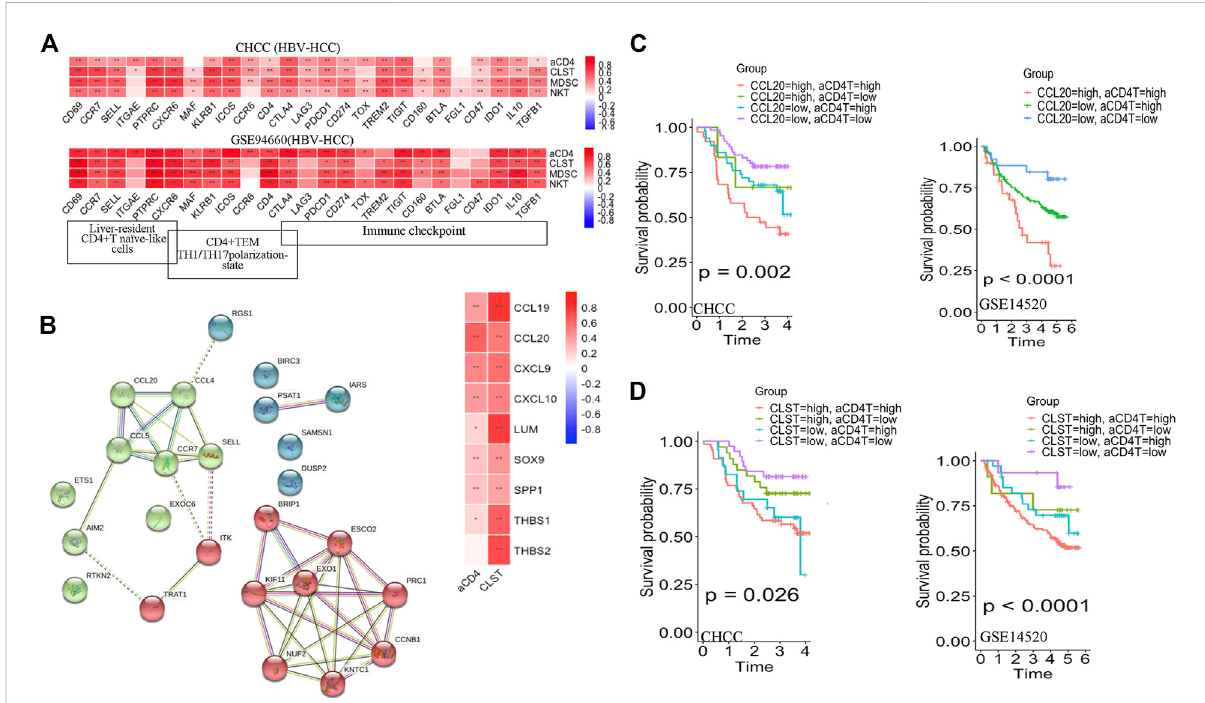
FIGURE 4 PrognosticvaluesofCLSTandaCD4forOSpredictioninHBV-HCC. (A) HeatmapsshowingcorrelationsbetweenCLST,aCD4,MDSC,NKT,and speci fi c immune genes in HBV-HCC. (B) PPI analysis of member genes belonging to aCD4 and correlations among aCD4, CLST, and hub gene expressionvalues.CCL20wasanoverlappinggeneinbothaCD4andCLST(GSE14520). (C,D) KMsurvivalanalysisofOSintumortissueswithahigher ES of both aCD4 and CCL20 or a higher ES of both aCD4 and CLST in two independent HBV-HCC cohorts. Time was calculated in years. The log-rank test for p -value and p -value < 0.05 was considered signi fi